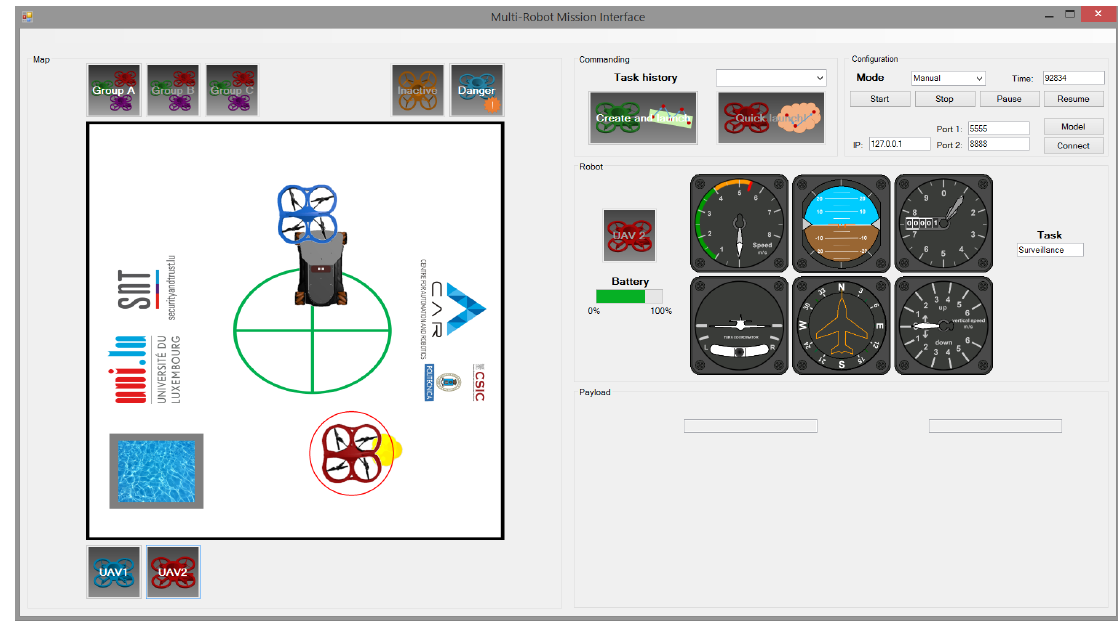
Figure 7. Conventional interface without the predictive